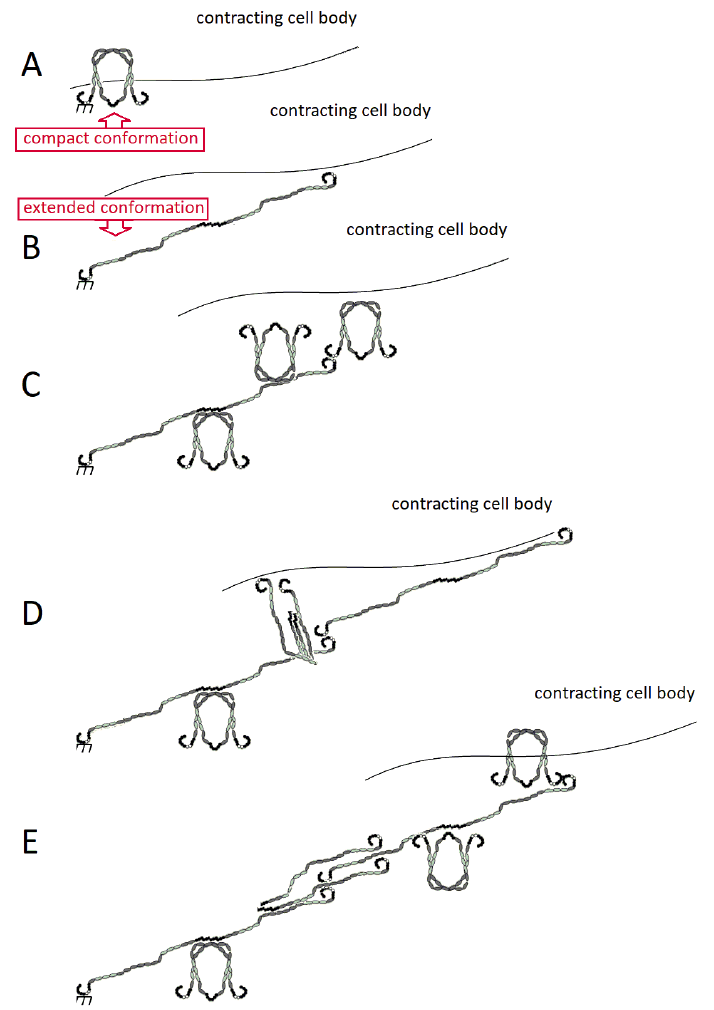
Figure 2. Assembly of FN fibrils from soluble FN. ( A ) FN exists in a soluble conformation, which binds to integrins on the cells surface. ( B ) Actomyosin force extends FN, facilitating ( C ) FN–FN binding. ( D ) As additional soluble FN molecules bind to the fibril, additional integrin binding drives progression and assembly of an insoluble fibril. ( E ) FN–FN interactions are detailed in the text, and involve interactions between homotypic Type I domain (black circle) interactions, and heterotypic Type I and Type III domain (gray oval) interactions.